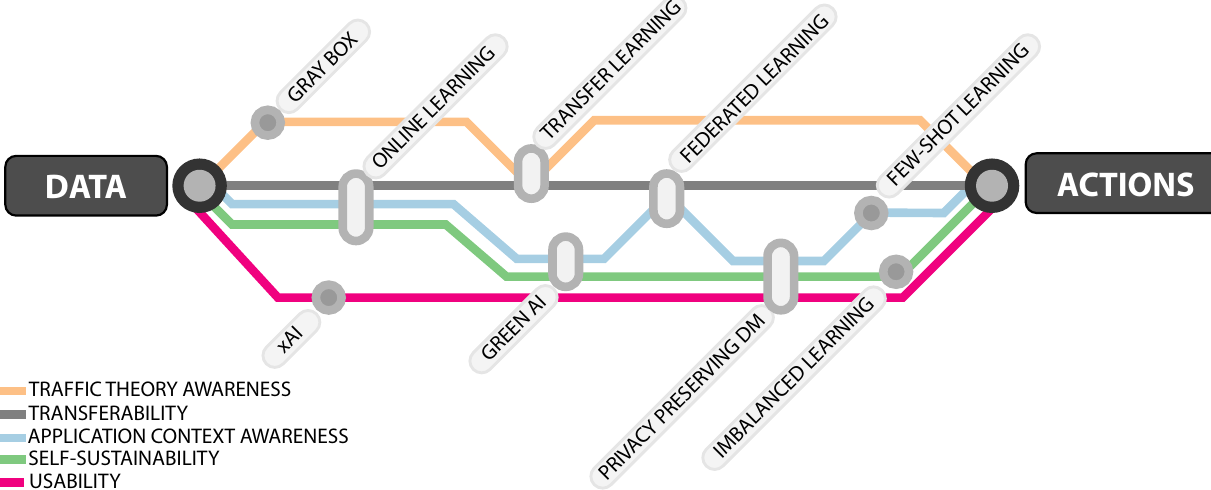
Figure 3. Schematic diagram showing how avant-garde AI subareas can promote actionability in ITS data-based modeling workflows. Subareas contributing with particular emphasis to different functional requirements are connected together along the way from data to